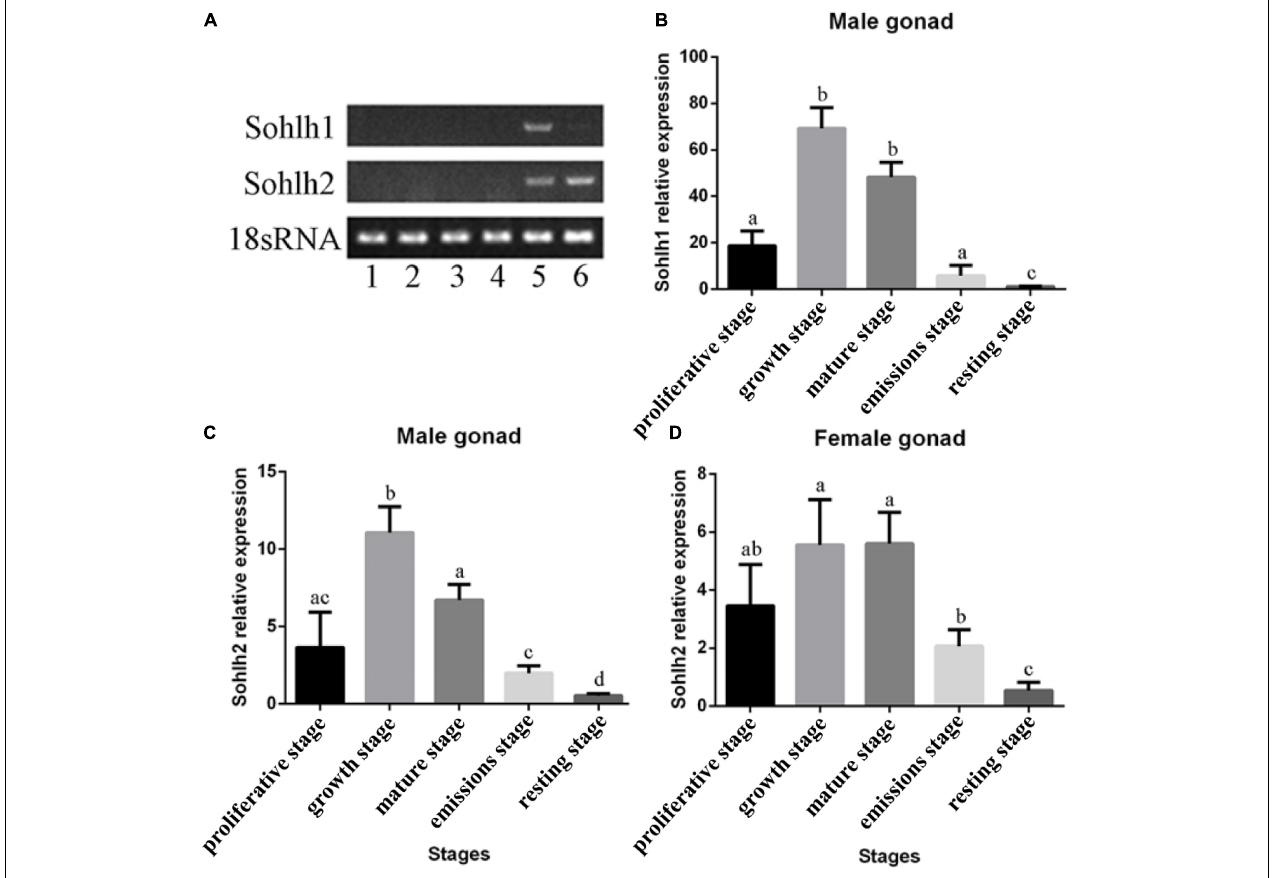
FIGURE 4 | Expression analysis of the transcriptional regulator SOHLH in Crassostrea gigas . (A) The mRNA expression of Sohlh in different adult tissues was determined by RT-PCR. 1, digestive gland; 2, gill; 3, adductor muscle; 4, mantle; 5, male gonad; 6, female gonad. (B–D) The Sohlh mRNA expression is shown during gonadal development. The expression levels were calibrated against the resting stage (control). The vertical bars represent the mean ± SD., n = 5. “a, b, and c” indicate significance to each other ( p < 0.05).